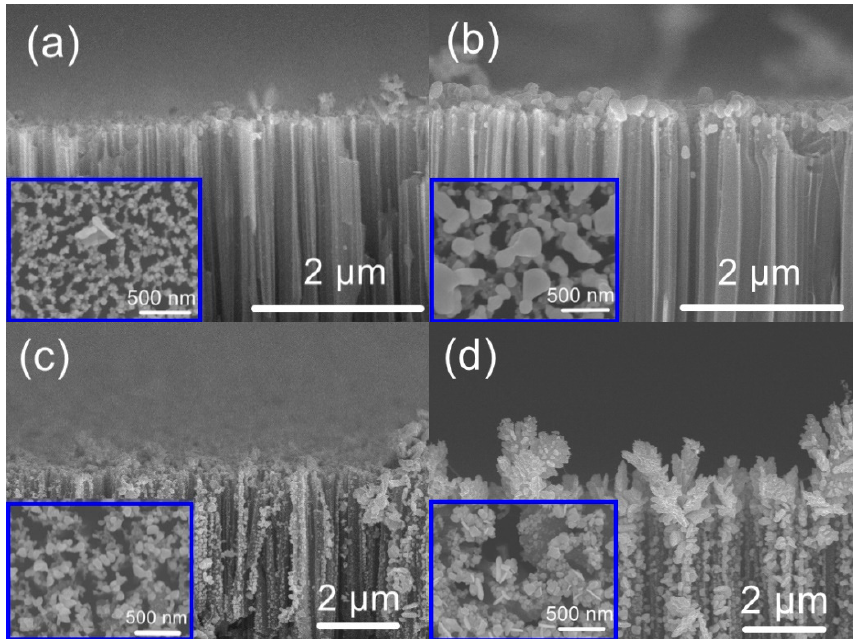
Figure 3. SEM images of silicon nanowire arrays coated with silver nanoparticles using Ag + solutions with concentrations of ( a ) 1.25, ( b ) 2.5, ( c ) 5, and ( d ) 10 mM in conjunction with a UV irradiation time of 10 min.